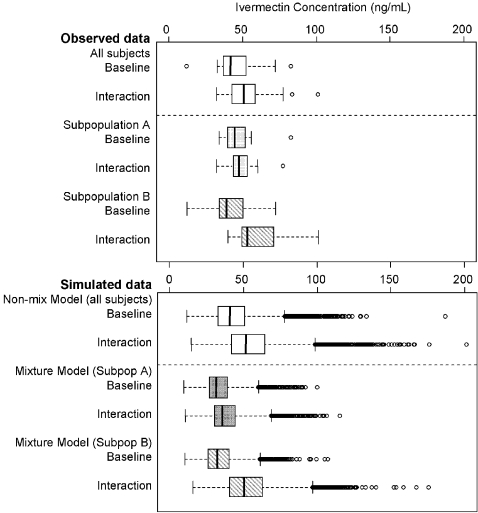
Upper panel: Observed maximum ivermectin concentration data in baseline and interaction arms from all subjects (open boxes) and from subpopulations A and B (shaded and hatched boxes).Lower panel: Maximum concentration data from 1000 simulation replicates using the non-mixture model in all subjects (open boxes) and from the mixture model in subpopulations A and B (shaded and hatched boxes). The line in the interior of the box denotes the median, the bottom and top edges denote the first and third quartiles, respectively. The lines from the top and bottom edges extend to 1.5 times the interquartile range. Values exceeding the interquartile range are plotted as individual points.